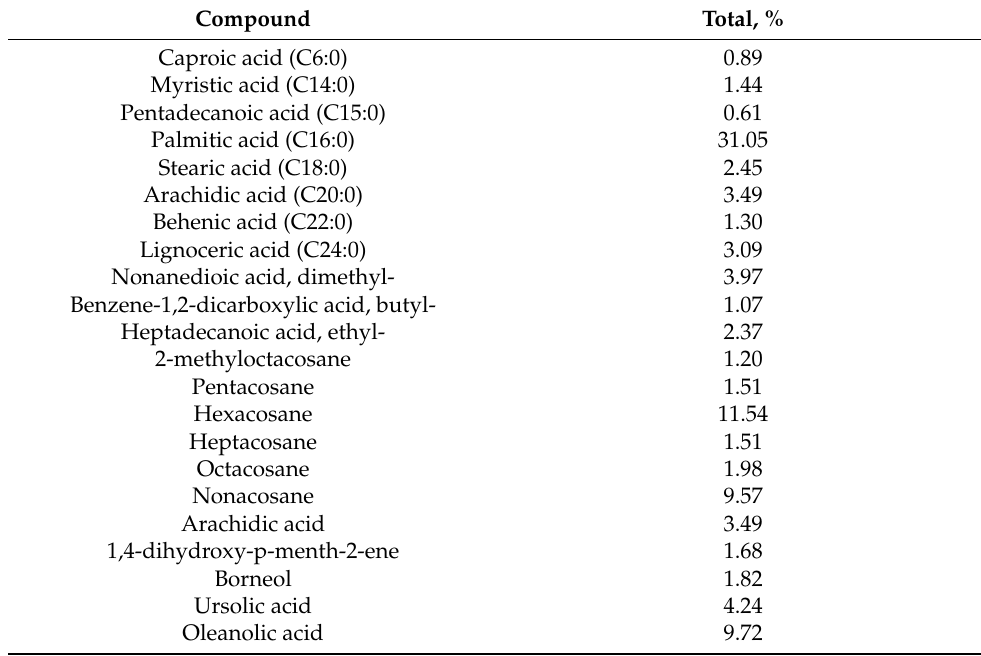
Table 4. Lipid components in the T. baicalensis